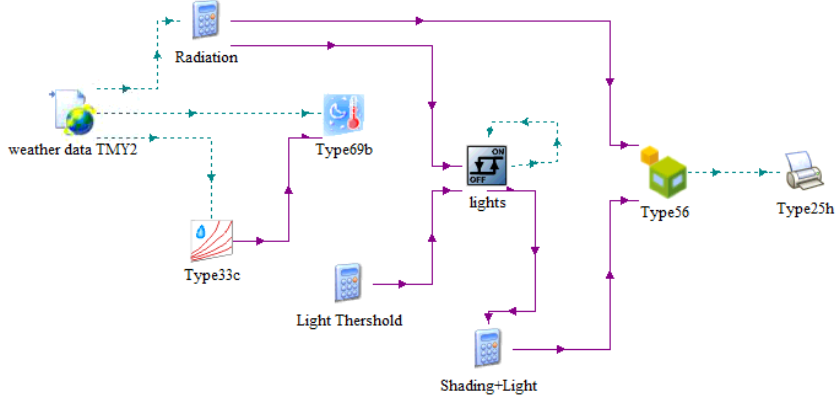
Figure 1. TRNSYS house load model set up.